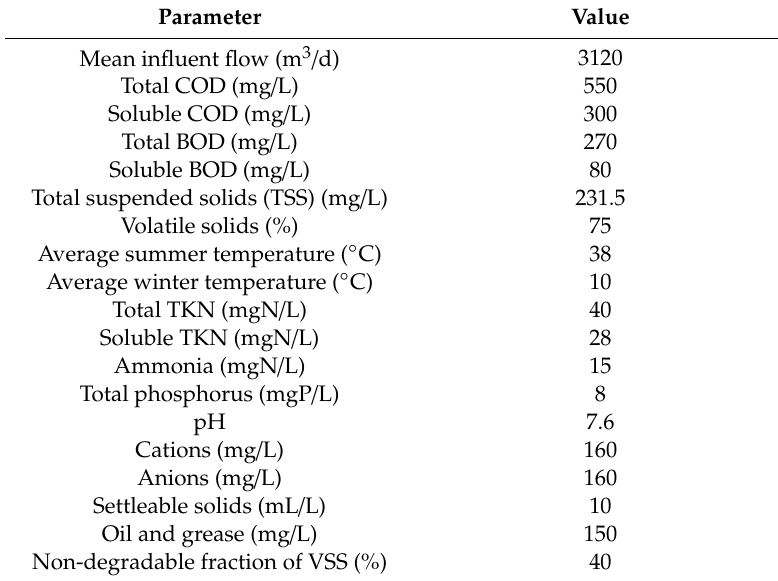
Table 1. The characteristics of influent wastewater (API e ffl